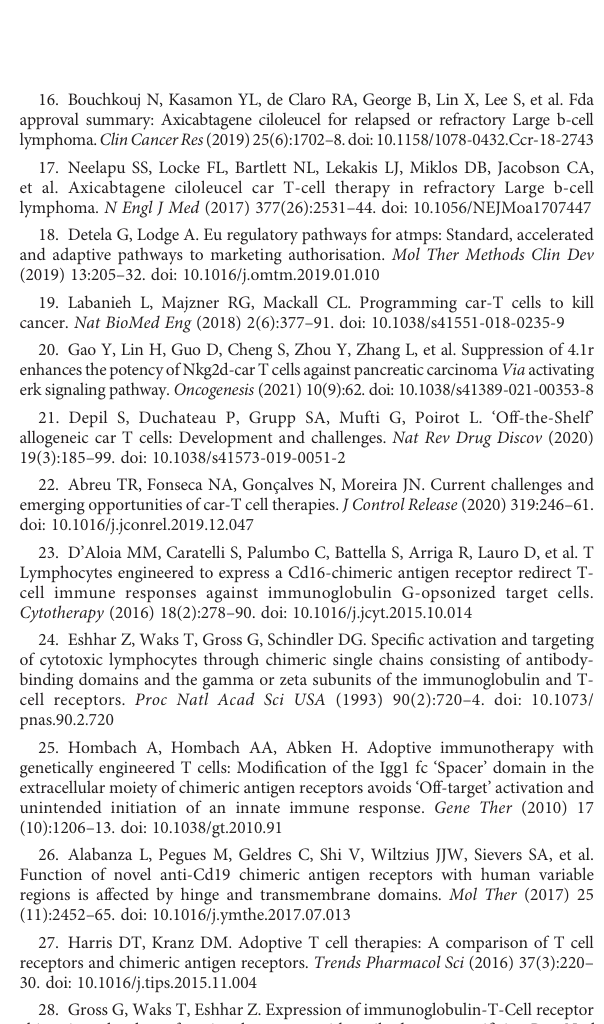
SUPPLEMENTARY FIGURE 1 Three main mechanisms of CAR T cell killing bile duct, pancreatic and gastric cancer